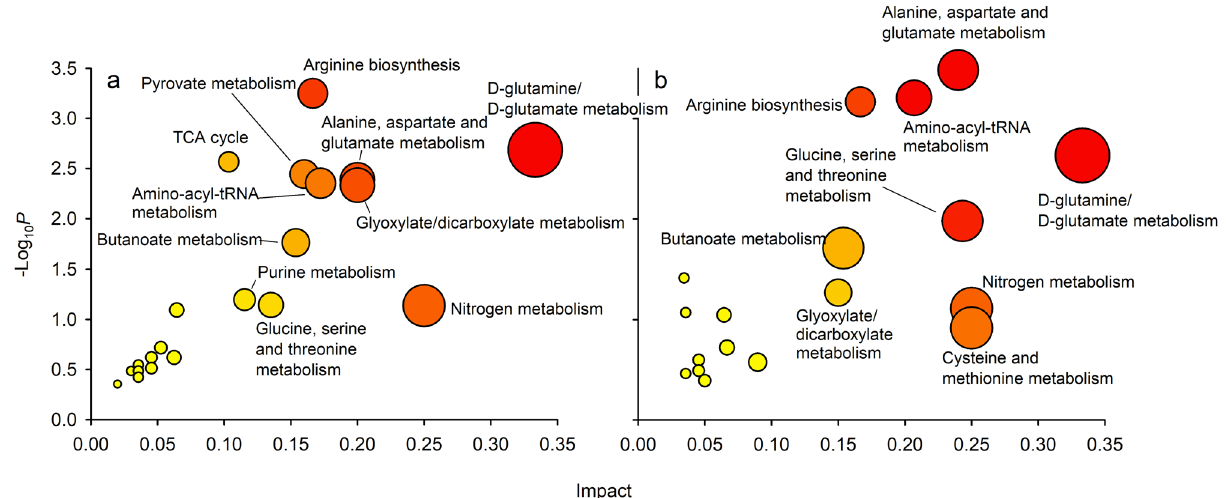
Figure 3. Metabolic pathway analysis (MetPA) results showing pathways affected by pH. ( a ) Copepodite stage CIV, ( b ) copepodite stage CV. The analyses were based on the hypergeometric test enrichment method and out-degree centrality pathway topology on the Drosophila melanogaster reference library. Y-axis show the significance of the test ( p -value) and x-axis show the impact of the tested molecules on the pathway. Bubble size and colour indicate pathway impact size. Thus, pathways in the top right diagonal region contain significantly changed metabolites and, due to their important positions, these changes are more likely to have big impacts on the pathways.